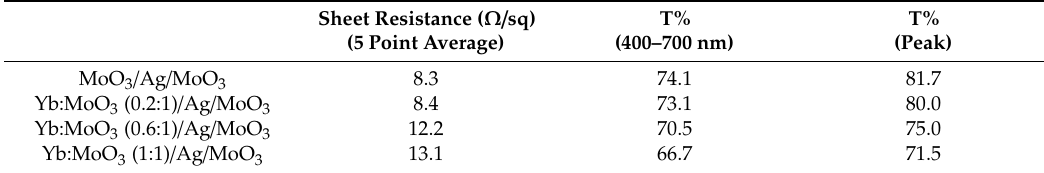
Table 1. Sheet resistance and optical transmittance with di ff erent Yb doping ratios in inner MoO 3 . Sheet Resistance ( Ω / sq) (5 Point Average)